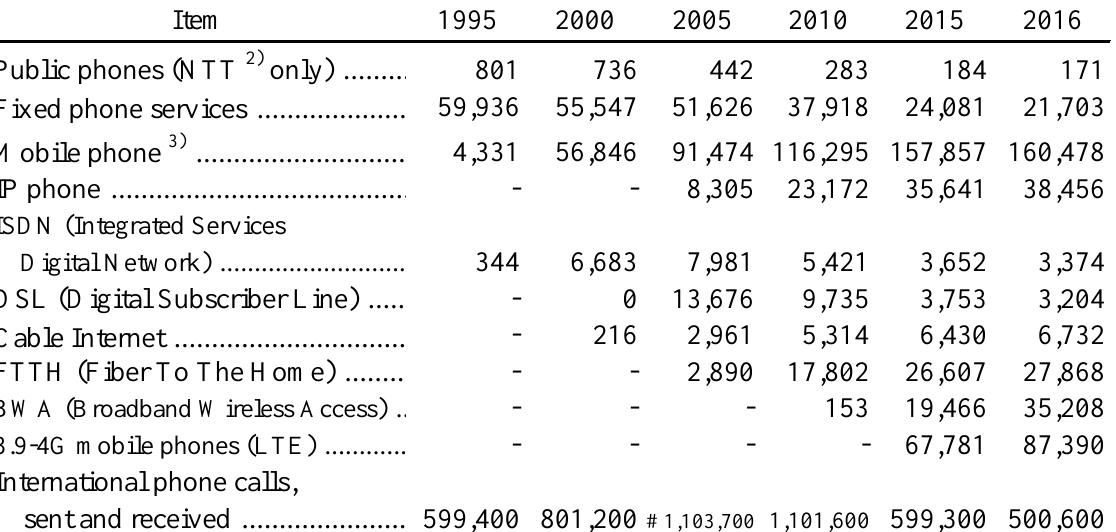
Subscribers to Telecommunications Services